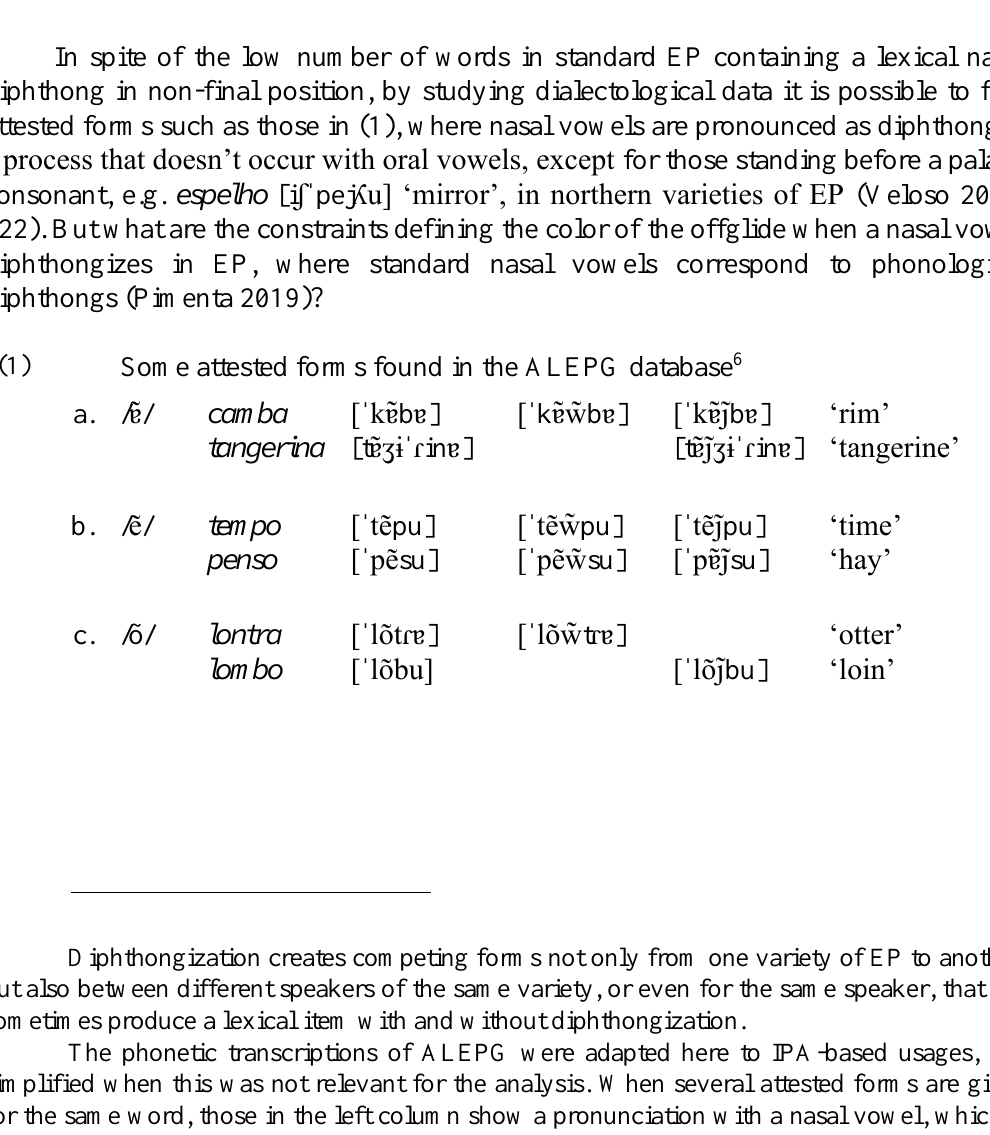
Source: Percentages were calculated based on the data presented by Vigário, Martins & Frota (2006: 682). In the present table, ‘Non-final position’ regroups the original ‘Initial’ and ‘Internal’ positions, while ‘Final position’ regroups the original ‘Final position’ and ‘Monosyllabic words’. Finally, ‘Nasal vowel (C)Ṽ’ regroups the original syllable types ‘CVN’ and ‘VN’, while ‘Nasal diphthongs’ represent the original syllable type ‘CVGN’. Unfortunately, the authors make no reference to stressed and unstressed